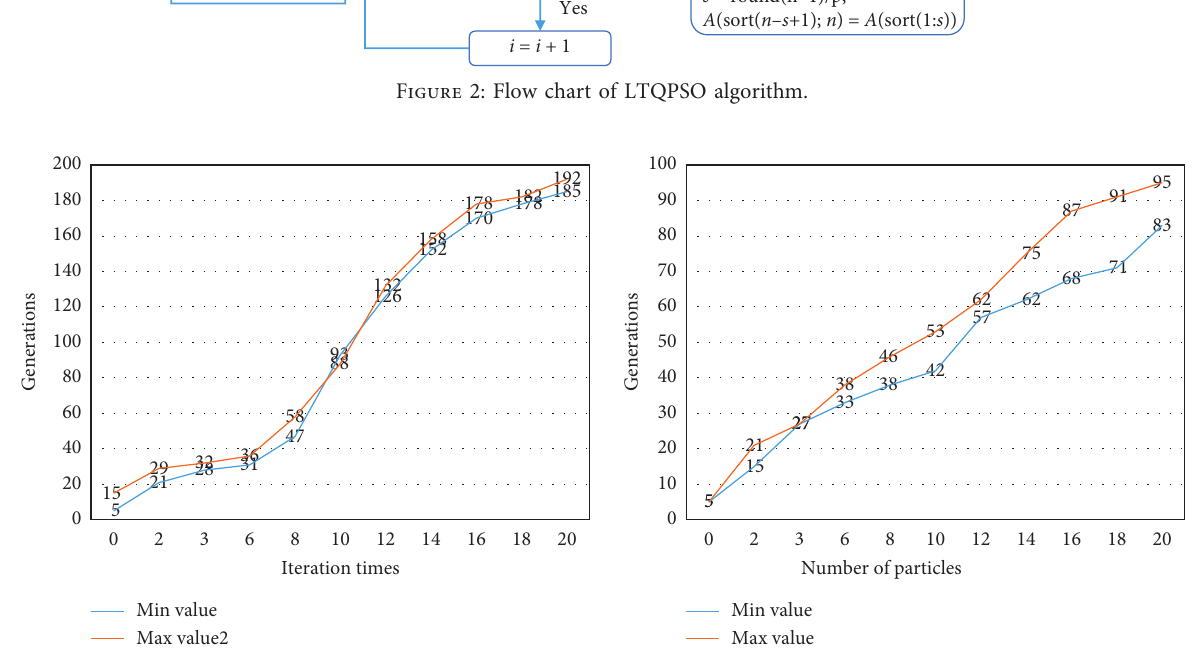
Figure 3: Simulation results of uniform